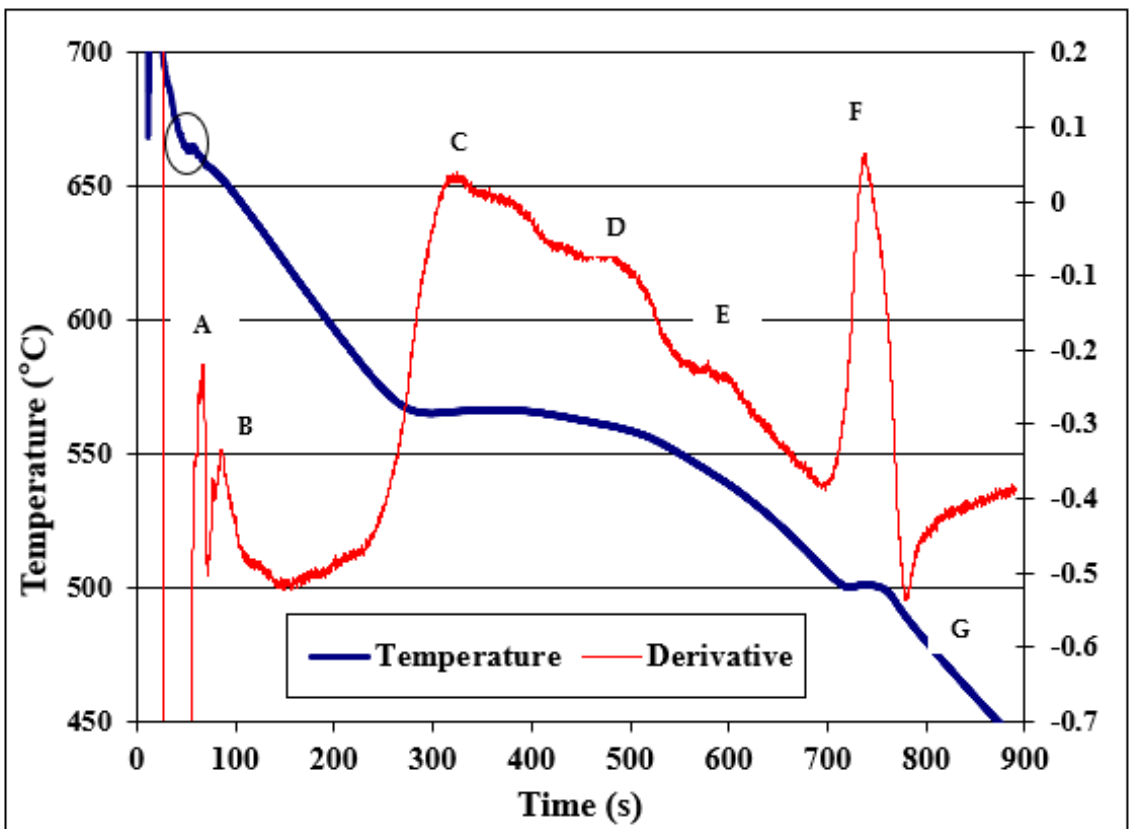
Figure 16. Thermal analysis curve and first derivative of an A390 alloy (17%Si) as cast at a solidification rate of ~0.8 °C/s in a preheated graphite mold. Note undercooling circled at the top left on the blue solidification curve. The letters A to G correspond to the reactions listed in Table 2.